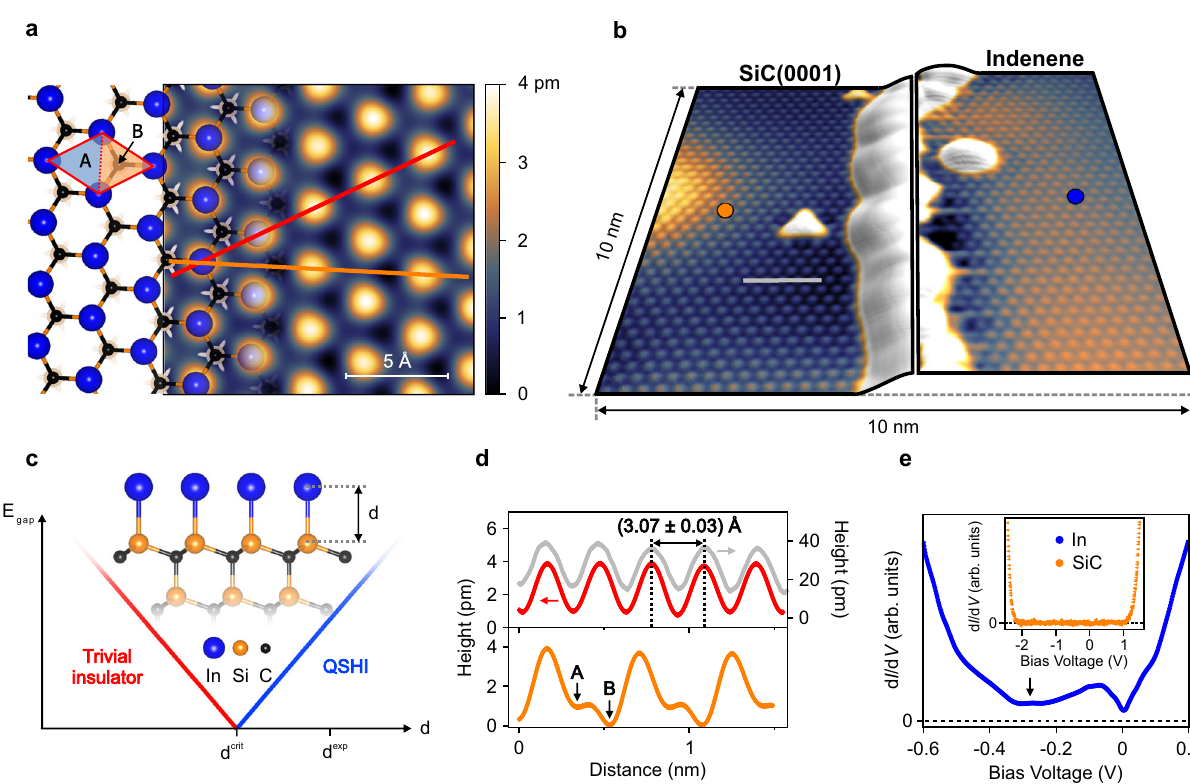
Fig. 3 Triangular indium monolayer on SiC(0001). a STM topography image (constant current mode with V set = 1.5 V and I set = 50 pA) of indenene next to the structural model illustrating the triangular atom lattice forming on the SiC(0001) substrate. Also shown is the (1 × 1) unit cell with its inequivalent A and B halves. At the chosen bias voltage STM probes essentially the out-of-plane In p z orbitals such that the bright spots directly re fl ect the positions of the In atoms. b Film edge between an indenene monolayer and uncovered SiC. Both lattices appear structurally identical but are distinguishable by